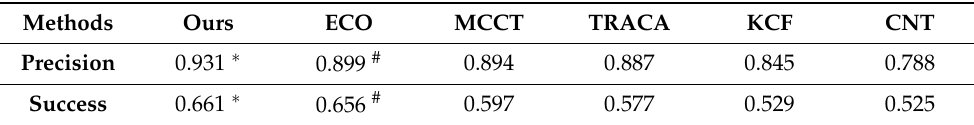
Figure 27. Quantitative results for all sequences in color. Table 4. The details of quantitative results. The best and the second best results are marked by symbols * and #,